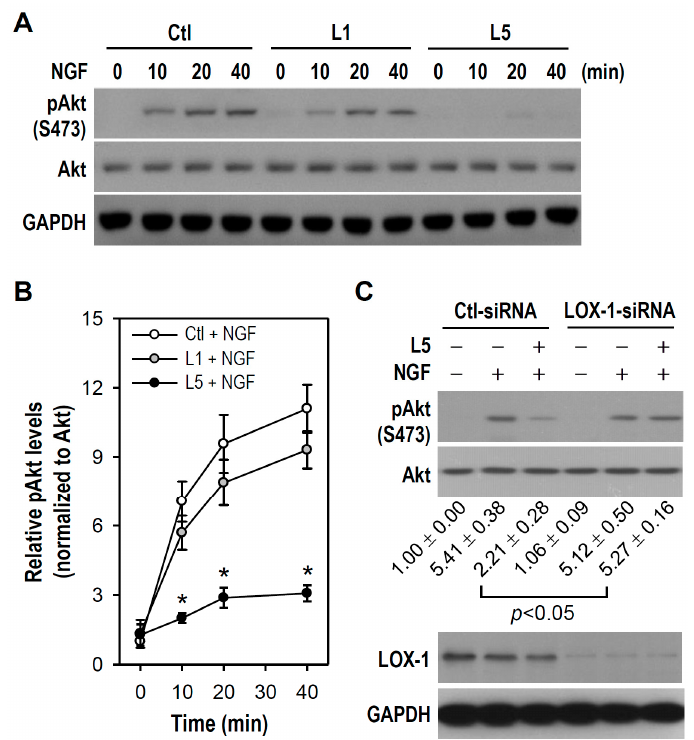
Figure 8. LOX-1 knockdown abolishes L5-induced Akt phosphorylation decline in NGF-treated PC12 cells. ( A ) Cultures were treated with L1 or L5 (10 μ g/mL) for 1 h, followed by NGF (50 ng/mL) addition for the indicated time periods. Cells untreated with LDLs were used as a control. Western blotting